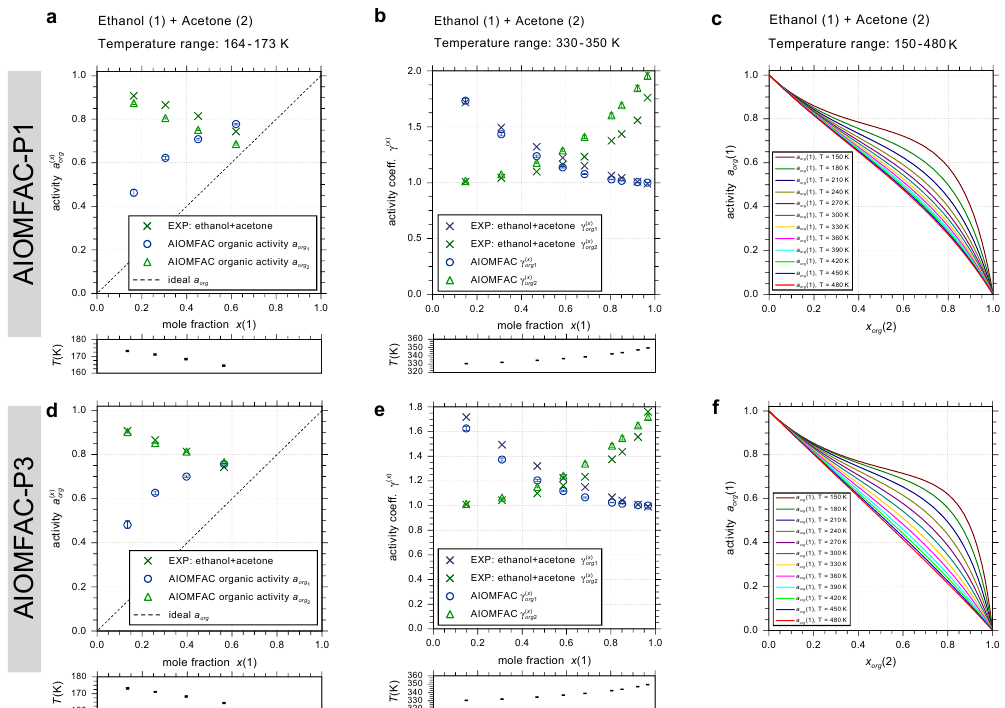
Figure 8. SLE and VLE measurements for ethanol (1) + acetone (2) solutions and corresponding calculations of AIOMFAC-P1 (a–c) or AIOMFAC-P3 (d–f) . Panels (c, f) show the temperature dependence as predicted by AIOMFAC-P1 and AIOMFAC-P3 for the temperature range 150–480K. (a, d) Low temperature experimental SLE data (crosses), shown as mole fraction of ethanol, x(1), vs. activity ( a (x) of acetone. The error bars represent the model sensitivity to a composition variation by x tol = 0 . 01. The dashed line is the ideal solution curve for component 1. Panels (b, e) show the model predictions of the activity coefficients compared to VLE data covering temperatures significantly higher than room temperature. The temperatures of the individual data points are given in the boxes below the main panels. Experimental data: Sapgir (1929) and Amer et al.